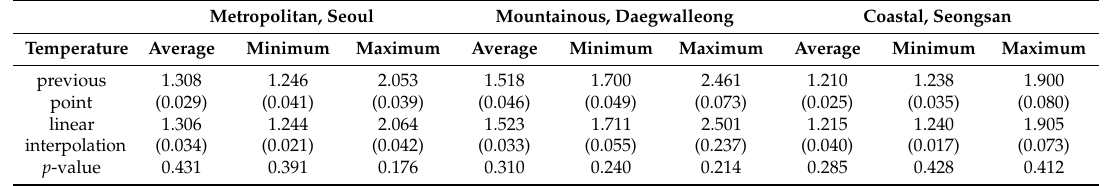
Table 19. Forecasting results, represented using the MAE for two imputation methods.